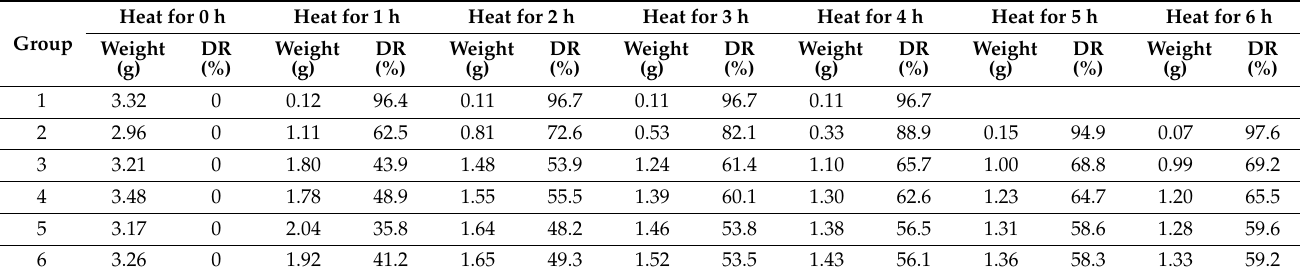
Figure 8. Optical photographs of the plugging agent after solidification in an oven. Table 4. Solubility of the plugging agent.